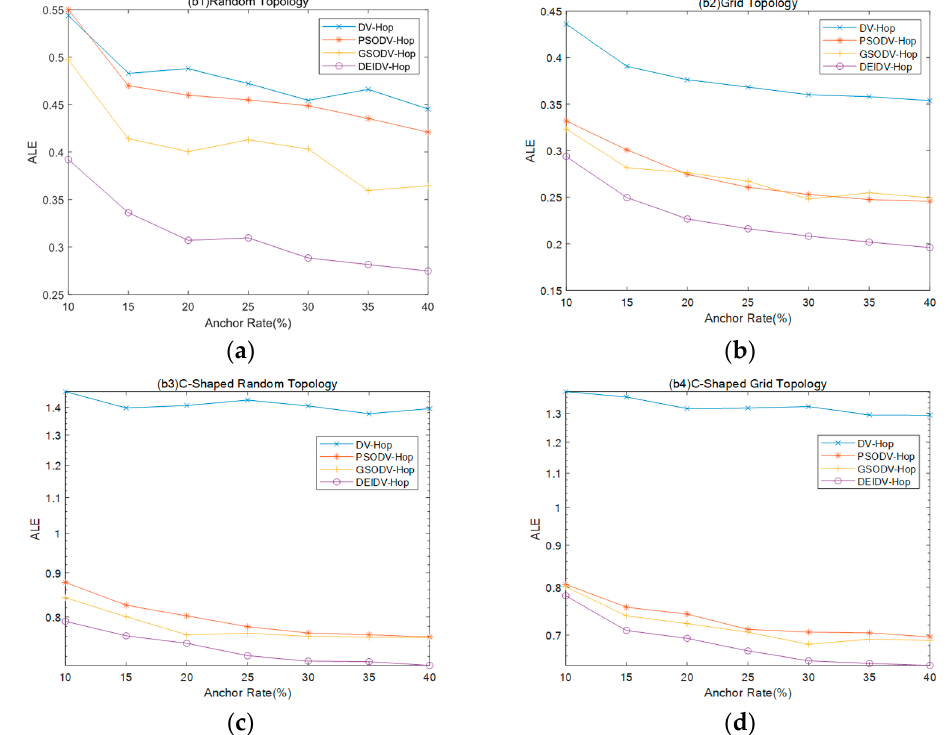
Figure 6. ( a ) E ff ect of the percentage of anchor nodes in square random topology on ALE; ( b ) E ff ect of Figure 6. ( a ) Effect of the percentage of anchor nodes in square random topology on ALE; ( b ) Effect the percentage of anchor nodes in square grid topology on ALE; ( c ) E ff ect of the percentage of anchor of the percentage of anchor nodes in square grid topology on ALE; ( c ) Effect of the percentage of nodes in C-Shaped random topology on ALE; ( d ) E ff ect of the percentage of anchor nodes in C-Shaped anchor nodes in C-Shaped random topology on ALE; ( d ) Effect of the percentage of anchor nodes in grid topology on C-Shaped grid topology on ALE.